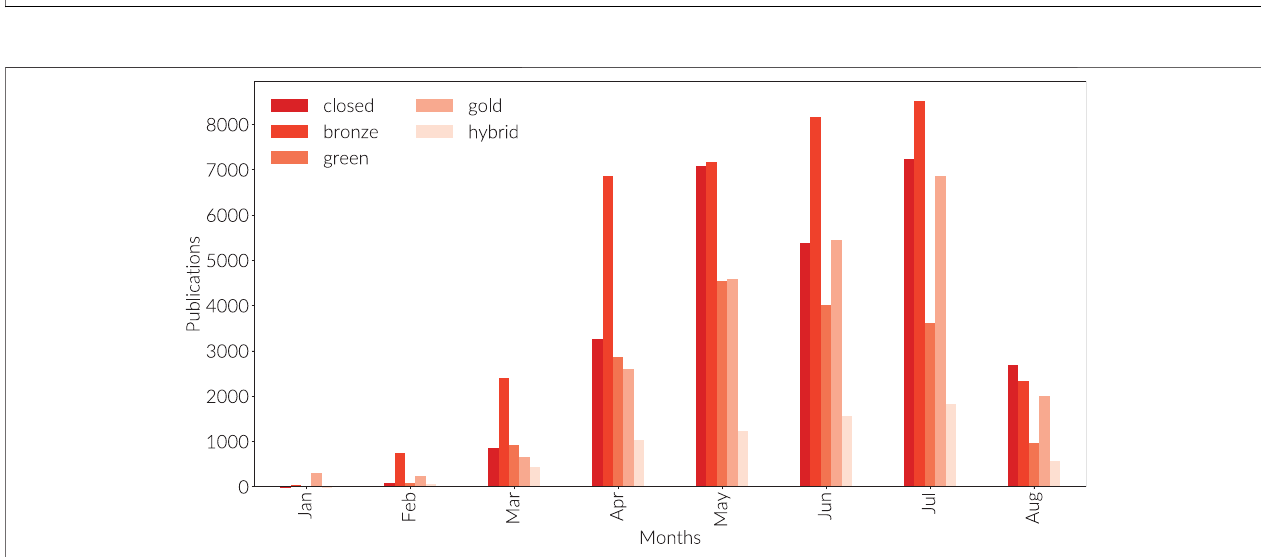
FIGURE 5 | Open Access research output resulting from querying with the boxed COVID search de fi nition in Dimensions. Outputs are grouped month by month and are not shown cumulatively. Output types as per the legend.